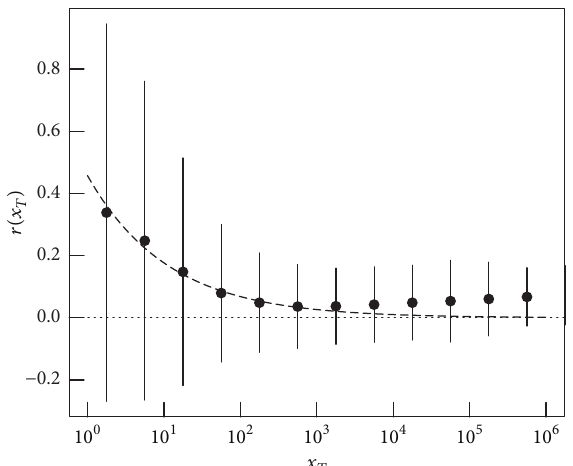
Figure 3: Scatterplot between logarithmical intermediate value = 10 0.5(𝑛−1/2) of each bin [10 0.5(𝑛−1) ,10 0.5𝑛 ] (𝑛 = 1,2,...,12) in 𝑥 𝑇 thousands of US dollars and logarithmic average value 𝑟(𝑥 𝑇 ) of 𝑟 in each bin in Figure 1. Standard deviations are also depicted as error bars. Dashed line is an optimal exponential curve for 𝑥 𝑇 < 10 3 , and dotted line is 𝑟(𝑥 𝑇 ) = 0